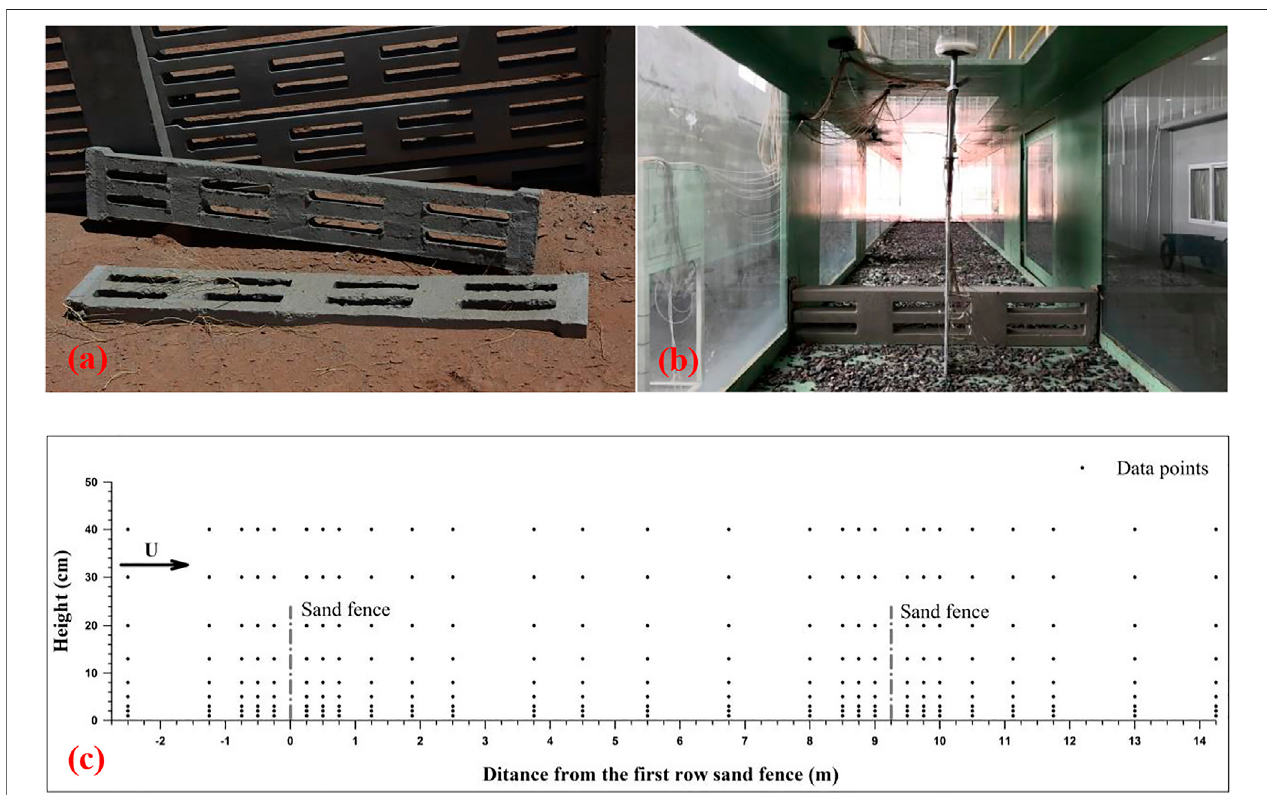
FIGURE 3 | (A) Horizontally aligned straight-installed plates used in the wind tunnel; (B) wind velocity pro fi les measured using pitot-static tubes; and (C) the positions of wind velocity measurement